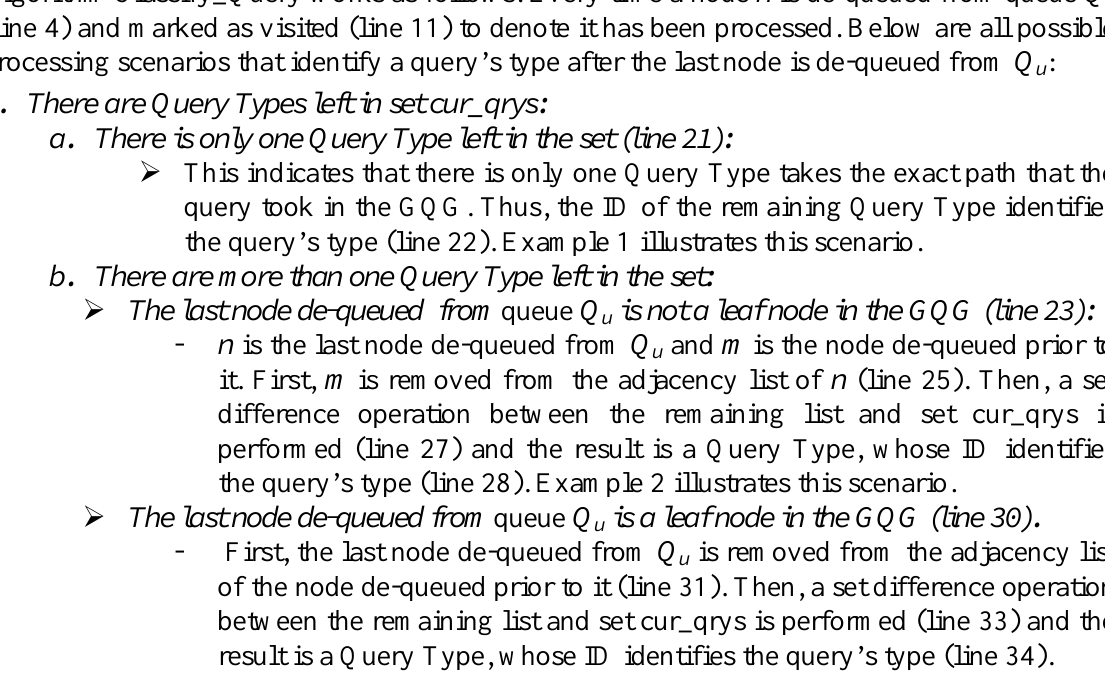
denotes node number i i